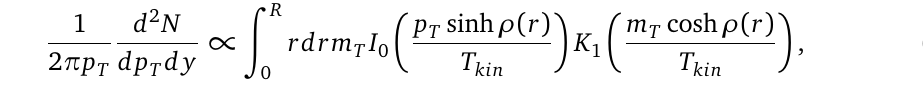
Figure 2: (top) dN / dy and (bottom) 〈 p 3 He, and 4 He in Au + Au collisions at data, open markers are reflected by measured ranges. The boxes indicate the sys- tematical